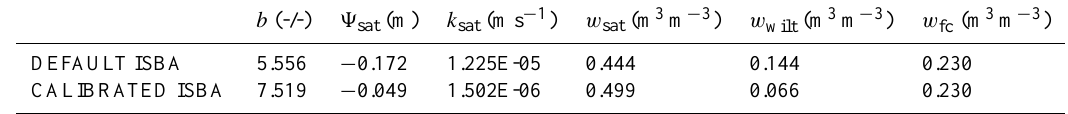
Table 4. Soil hydraulic values for Melbex 1 site calculated using the default and the calibrated set of equations. b (-/-) 9 sat (m) k sat (ms − 1 )